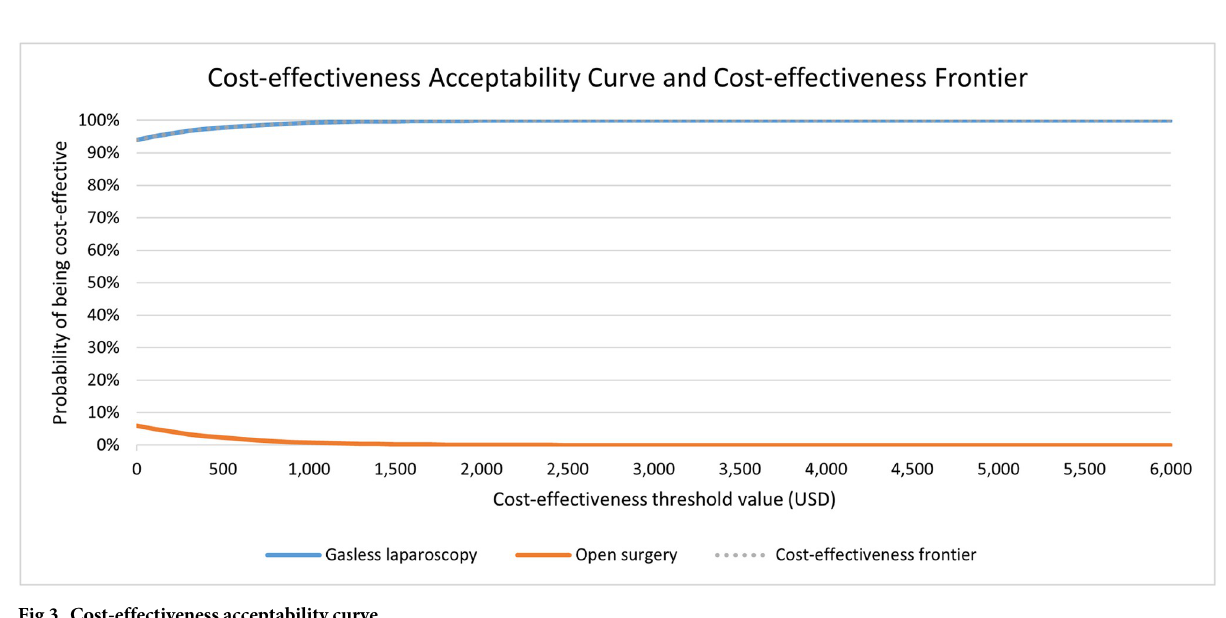
Fig 2. Cost-effectiveness plane.